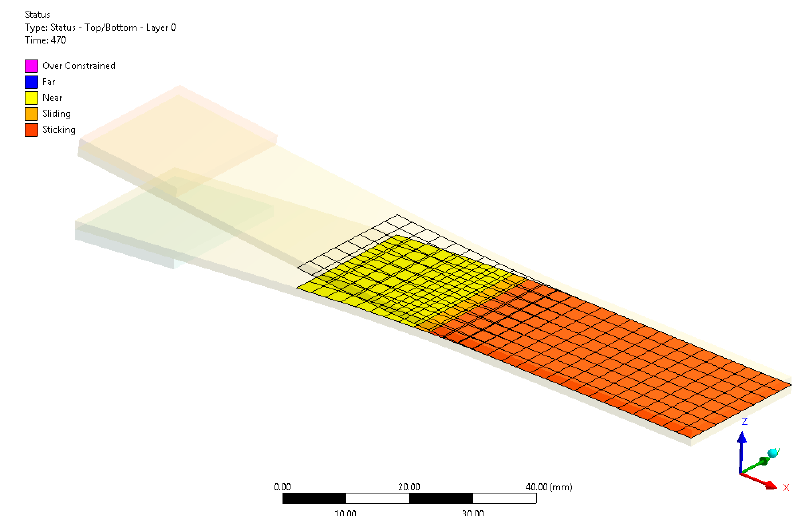
Figure 8. Contact elements and their status after flaw propagation.